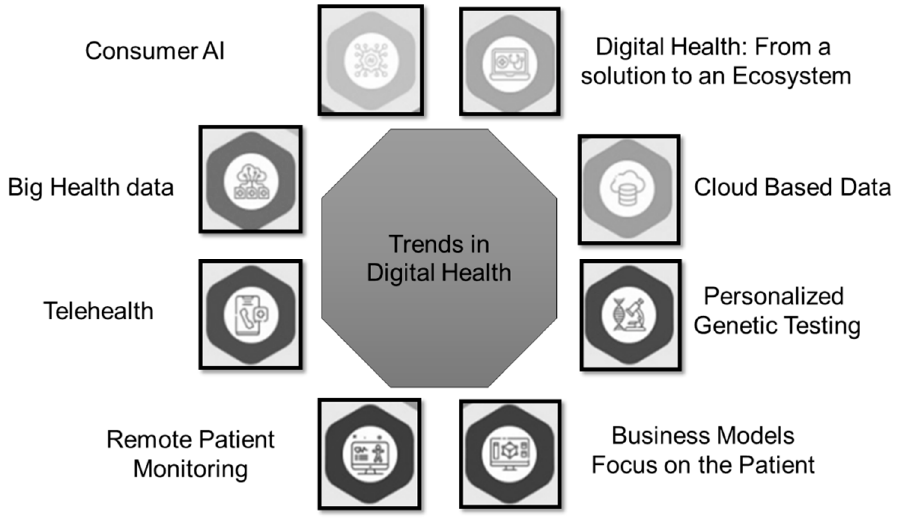
Figure 9. OST for Healthcare Applications.